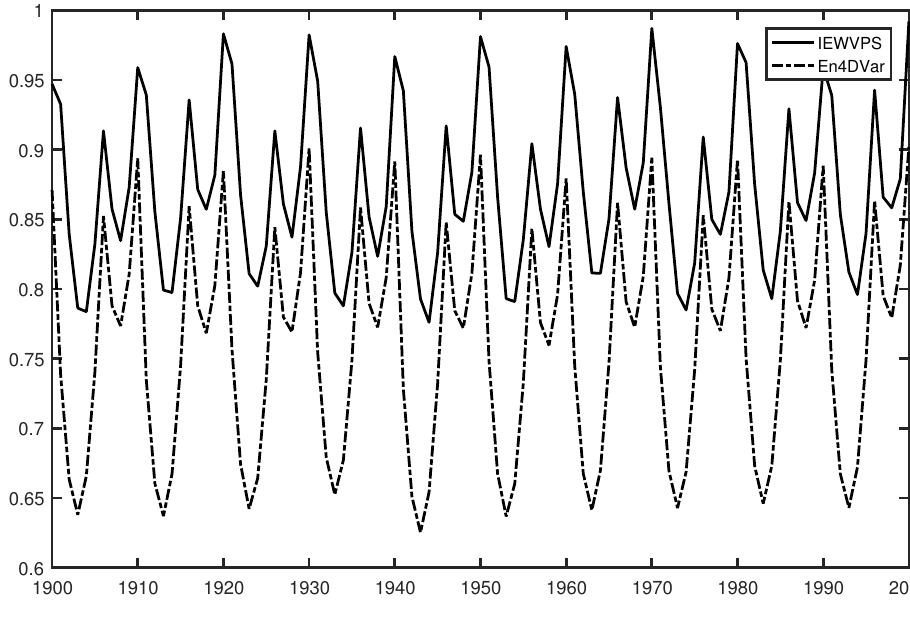
Figure 5. The ensemble spread over the last 100 model steps. The model dimension is N x = 100.